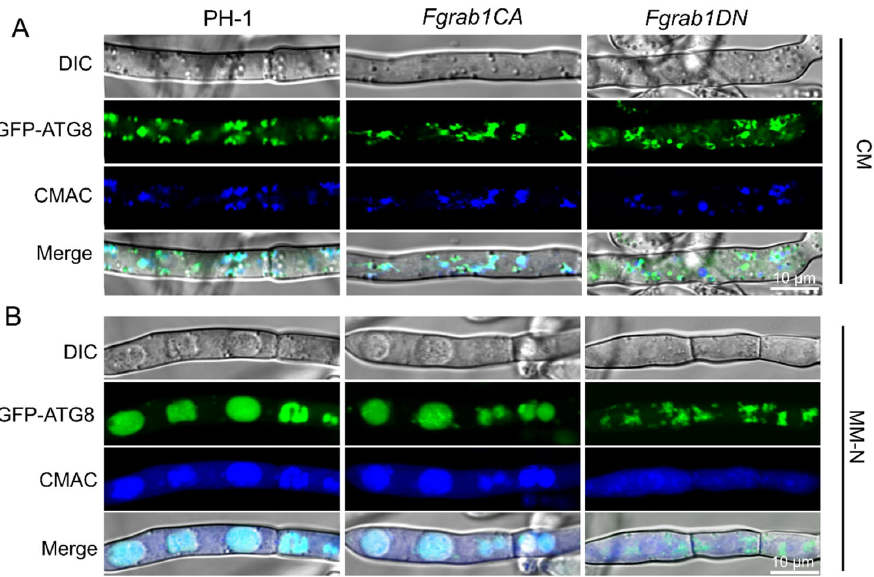
Figure 7. FgRab1 is required for autophagosome formation and autophagy in F. graminearum . Localization of GFP ‐ FgAtg8 in PH ‐ 1, Fgrab1CA and Fgrab1DN strains in CM ( A ) or MM ‐ N media ( B ). PH ‐ 1, Fgrab1CA and Fgrab1DN strains expressing GFP ‐ FgAtg8 were grown in liquid CM medium at 28 °C for 16 h and then shifted to liquid MM ‐ N medium containing 2 mM PMSF for 8 h to induce autophagy. Mycelia were stained with CMAC and examined under a confocal microscope. Bar = 10 μ m.